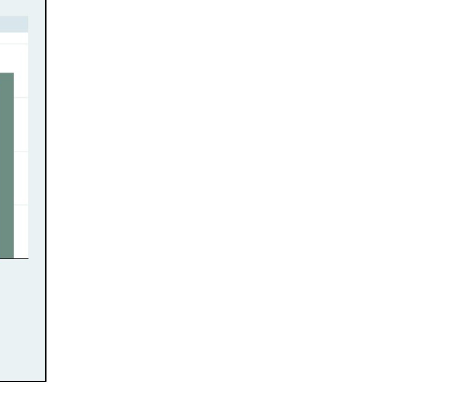
Fig 2. Gender and critical thinking